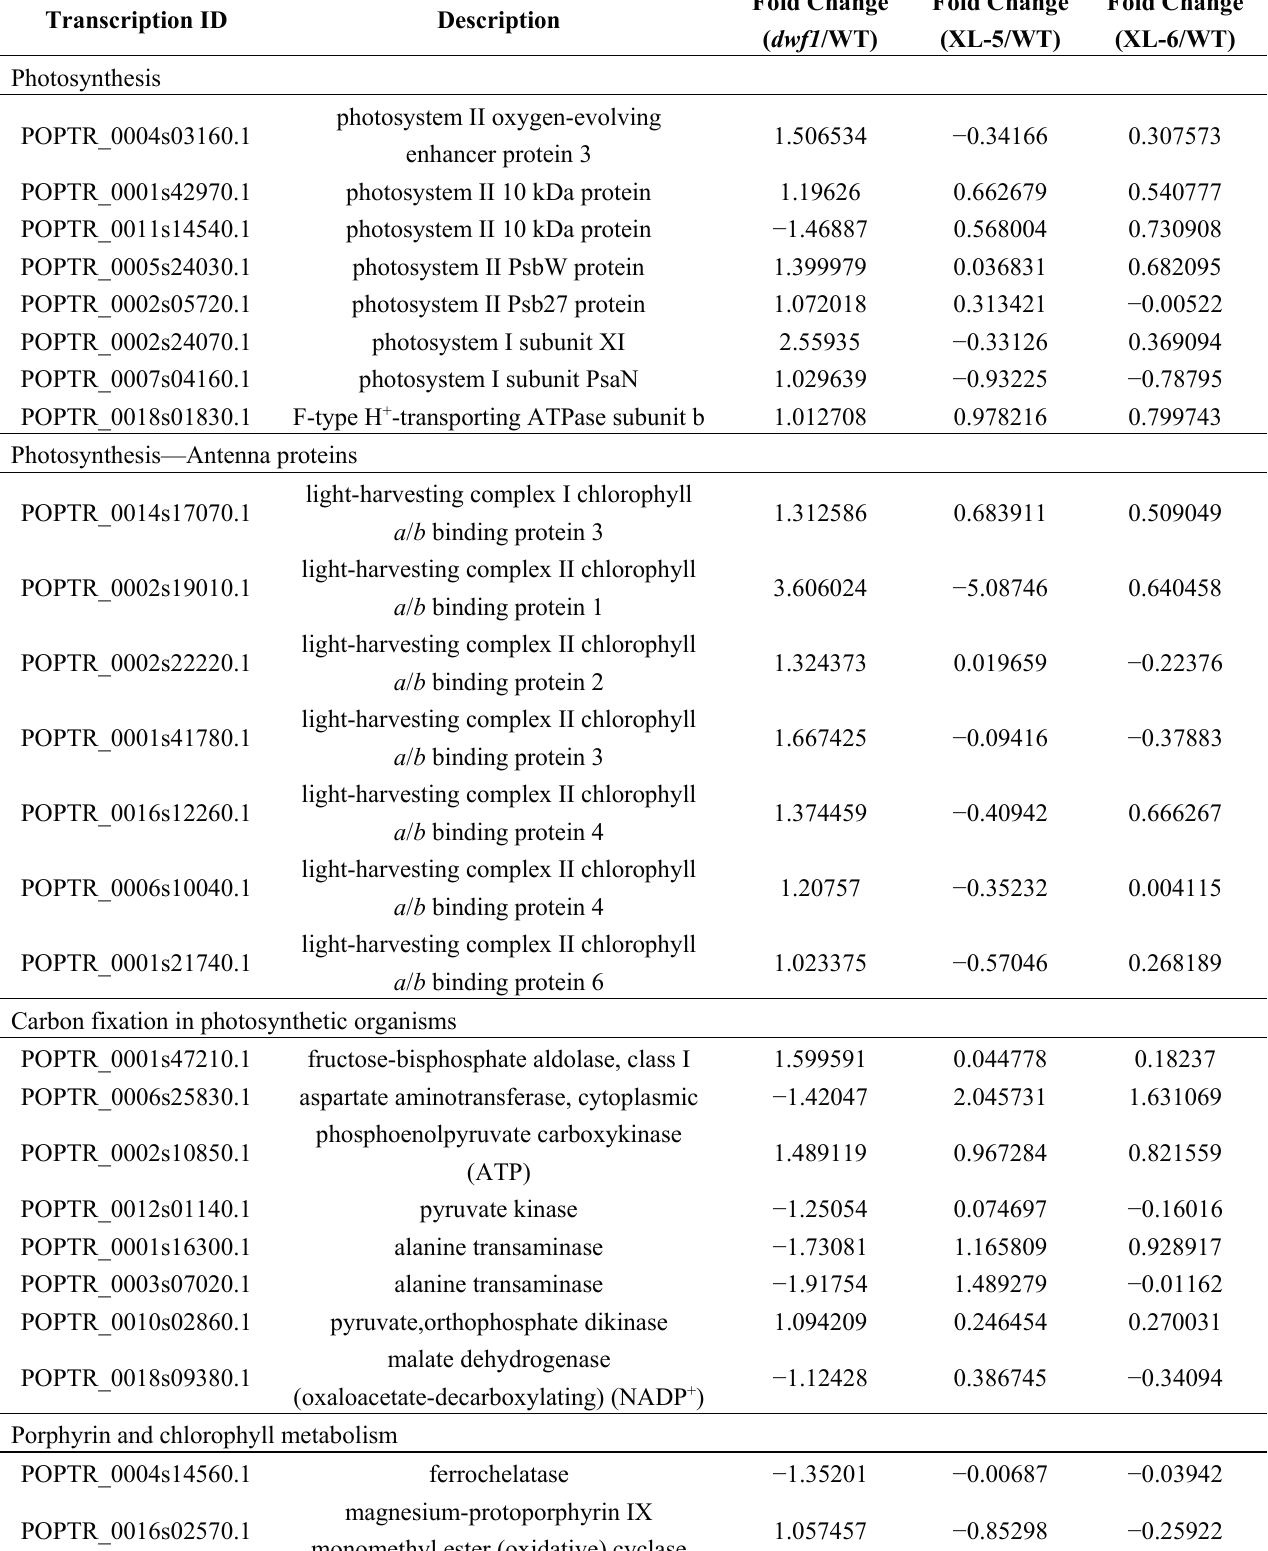
Table 2. Pathway analysis of the 1246 dwf1 -specific differentially expressed